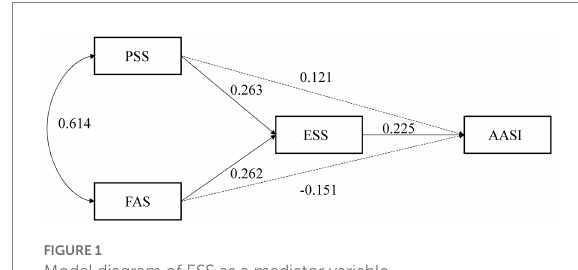
FIGURE 1 Model diagram of ESS as a mediator variable.